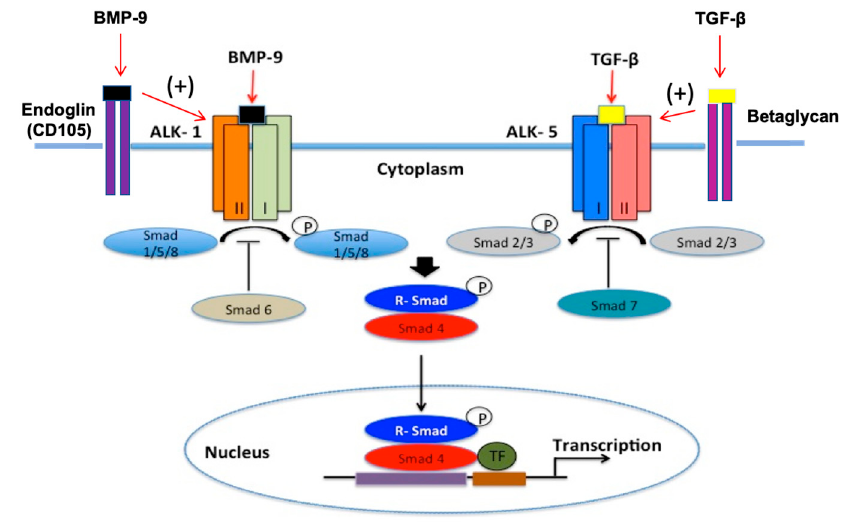
Figure 5. Transforming growth factor- β (TGF- β ) signaling at the brain microvascular endothelium.